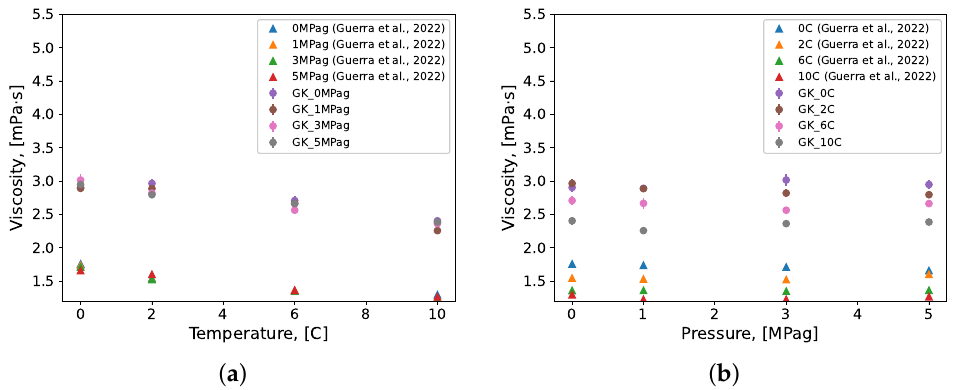
Figure 8. Viscosity of the methane gas hydrate systems as simulated by MD under pre-nucleation conditions using the TIP4P/Ice water force field model. Viscosity is presented as a function of ( a ) tem- perature and ( b ) pressure. Repeated simulation produced samples of each condition’s prediction value of size n = 10; these samples were bootstrapped with a replacement ( n = 10,000) to calculate mean values which are presented here with their standard error. Experimental values were collected and presented elsewhere by Guerra et al. [30]. GK: Green–Kubo